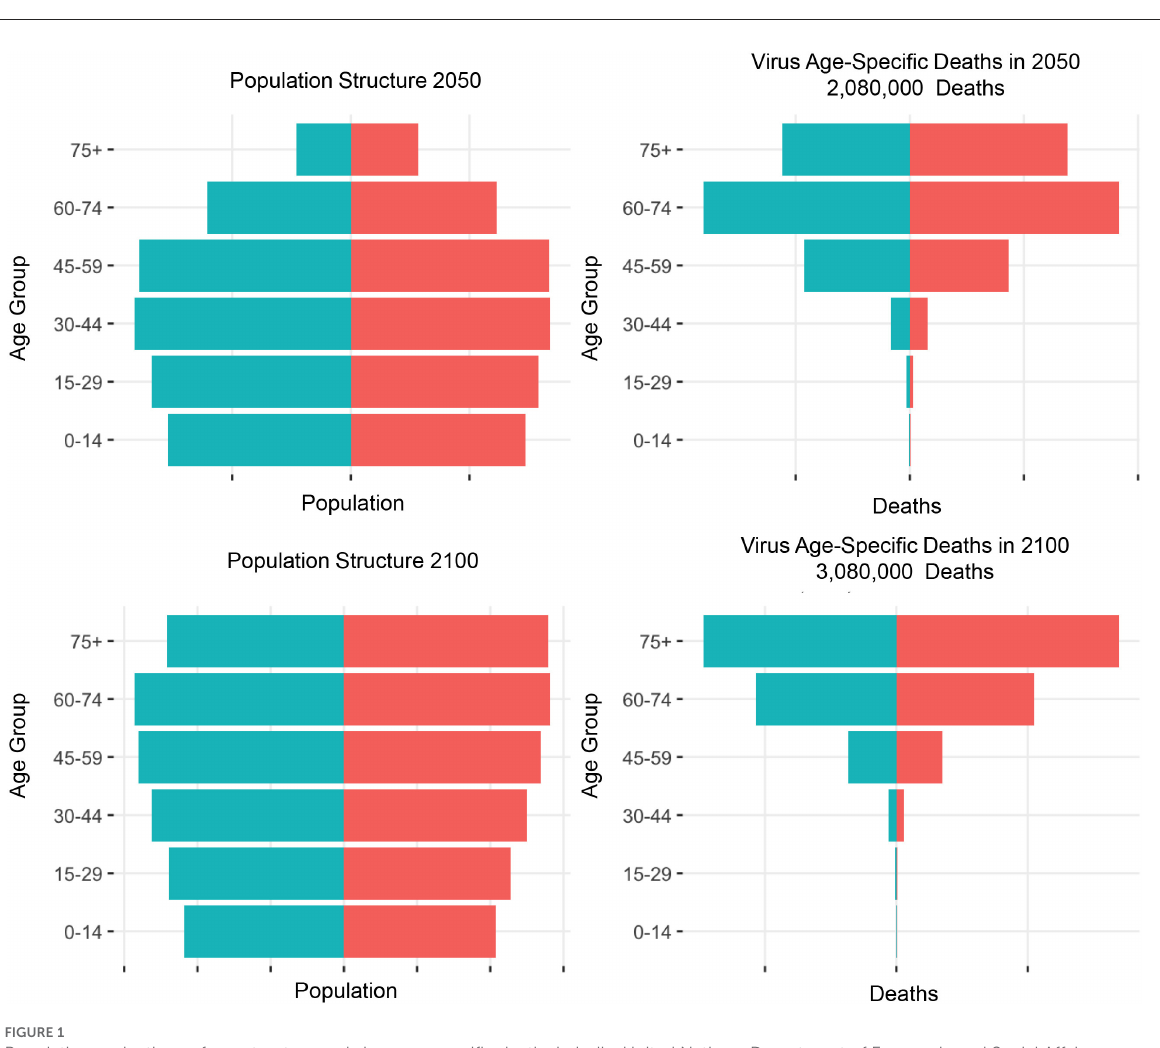
PPZ drafted Table 1. CS contributed to Figure 1. KLW and PPZ revised the commentary. PPZ, KLW, CS, and